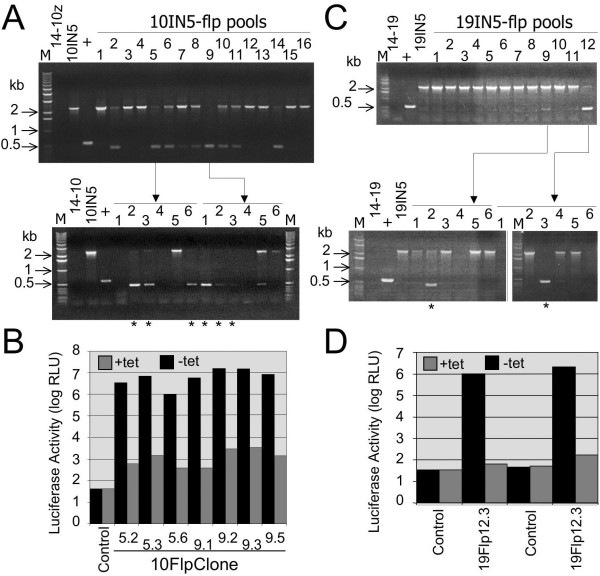
Flp-mediated deletion and resulting luciferase expression in Rht14-10IN5 and Rht14-19IN5. A. Ethidium bromide stained agarose gel of electrophoresed PCR products generated with the primers O2 and O4 (Fig. 4A) and cell pellets of Rht14-10, Rht14-10IN5, pTIGHTluc (+) and Rht10IN5flp pools (top, 1–16) or clones constituting Rht10IN5flp pools 5 and 9 (bottom). Positive controls (+) used pTIGHTluc DNA (expected product: 517 bp). B. Luciferase activity in lysates from clones indicated (*) in A, or control cells (Rh14-10), grown in the absence or the presence (for 48 h) of tet. C. Ethidium bromide stained agarose gel of electrophoresed PCR products generated with the primers O2 and O4 (Fig. 4A) and cell pellets of Rht14-19, Rht14-19IN5, and Rht19IN5flp pools (top, 1–12) or constituent clones of pools 9 and 12 (bottom, 1–6). Positive controls (+) were as in A. D. Luciferase activity in lysates from clones indicated (*) in C, or control cells (Rht14-19), grown in the absence or the presence (for 48 h) of tet. Results of two experiments are shown.